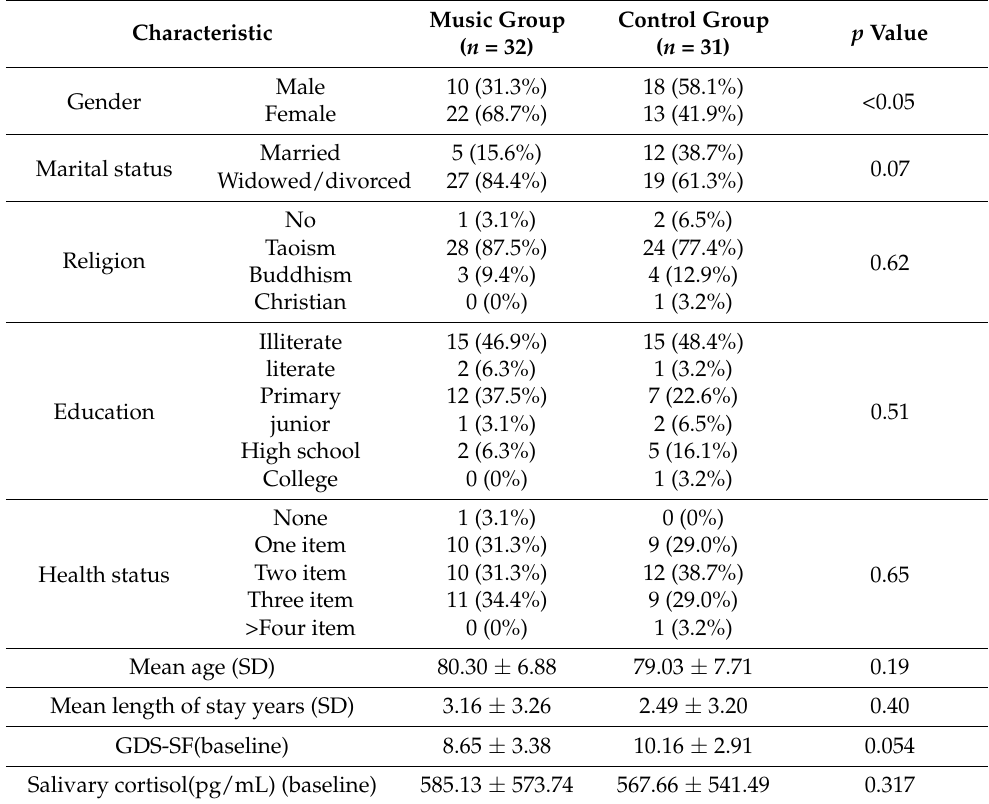
Table 1. Homogeneity of the general and clinical characteristics and variables among groups.